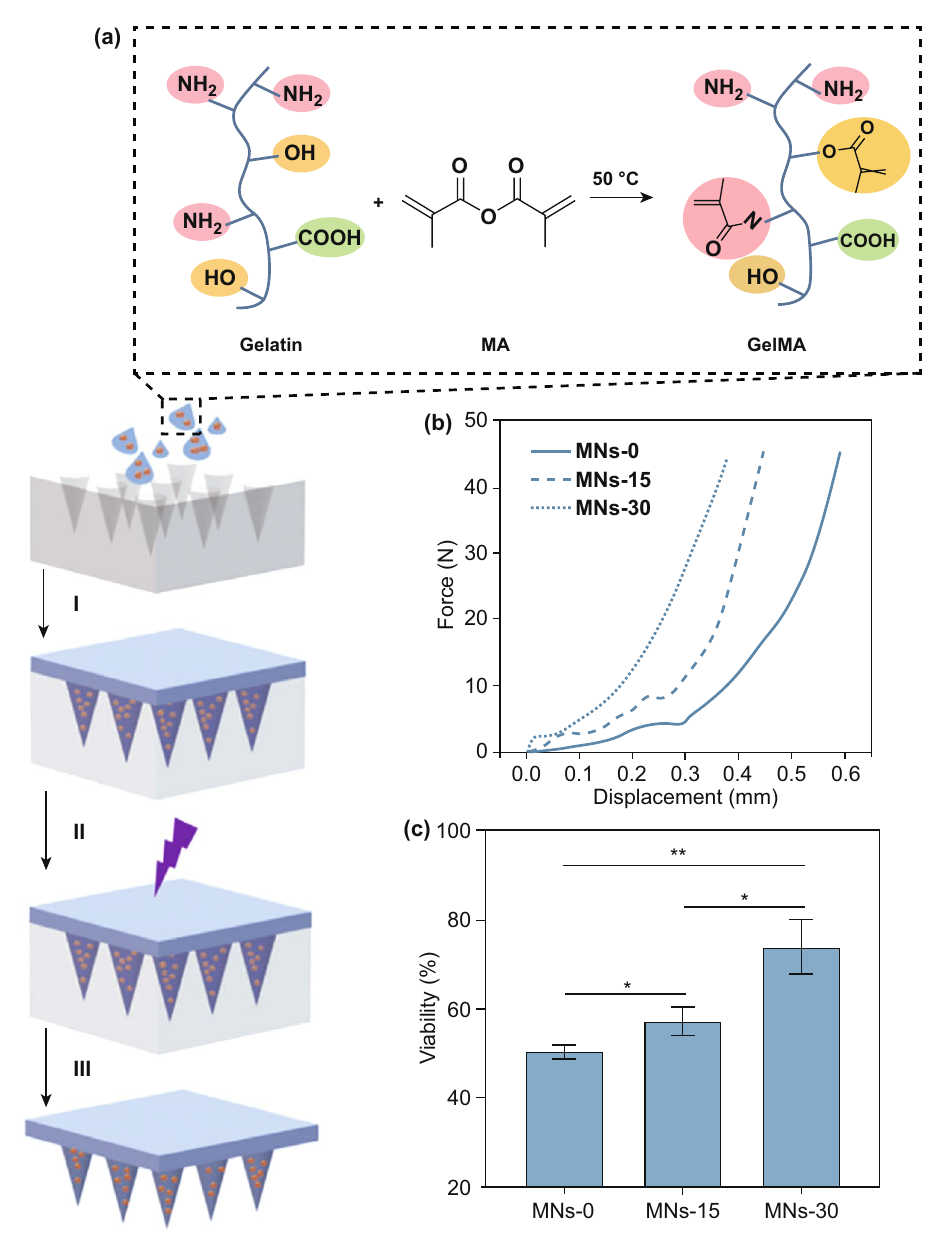
Fig. 13 a Schematic of MN arrays fabrication process by (I) centrifugation, (II) UV cross-linking, (III) overnight dry and peeled off from PDMS mold. Effect of the duration of cross-linking on the mechanical strength ( b ) and biocompatibility c of the microneedle patches based on gelatin methacryloyl (GelMa). The MNs that cross-linked for 30 s exhibited the highest cell viability, whereas MNs without cross-linking or those cross-linked in 15 s showed the lower cell viability. Reprinted from Ref. [188] with permission from